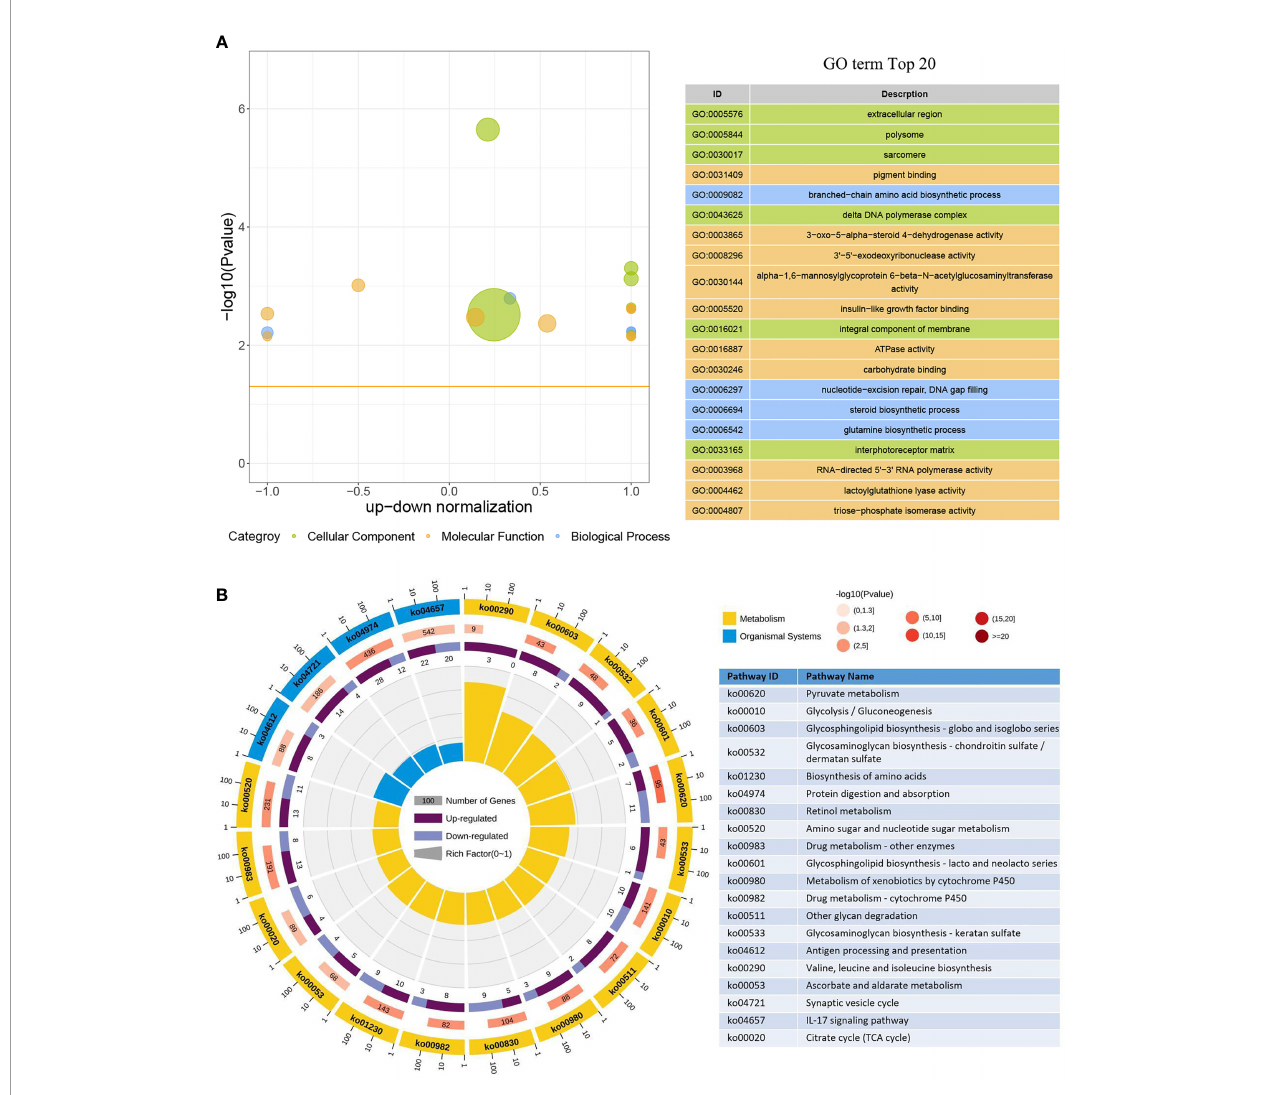
FIGURE 4 | GO term and KEGG pathway enrichment analyses of DEGs. (A) GO bubble plot showing a summary of the top 20 enriched GO terms (level 3). Different colors represent different GO categories, including biological process, cellular component, and molecular function. The x-axis indicates up – down normalization, and the y-axis indicates − log 10 ( p -value). (B) The fi rst lap indicates the top 20 KEGG pathways (level 3), and the number of genes corresponds to the outer lap. The second lap indicates the number of genes in the genome background and the Q -values for the enrichment of the DEGs for the speci fi ed biological process. The third lap indicates the ratio of the upregulated genes (deep purple) and downregulated genes (light purple). The fourth lap indicates the enrichment factor of each KEGG term. GO, Gene Ontology; KEGG, Kyoto Encyclopedia of Genes and Genomes; DEGs, differentially expressed genes.